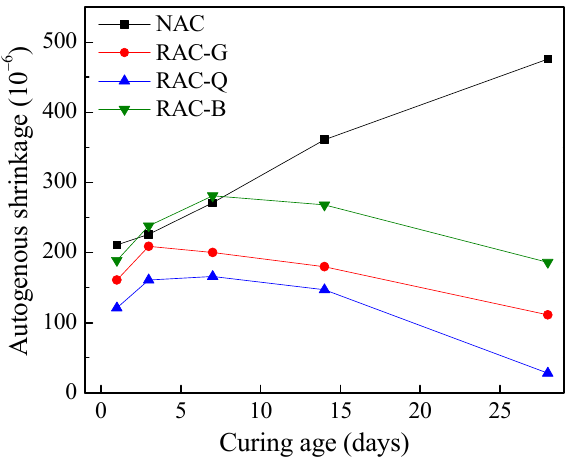
Figure 5. Autogenous shrinkage of concrete.